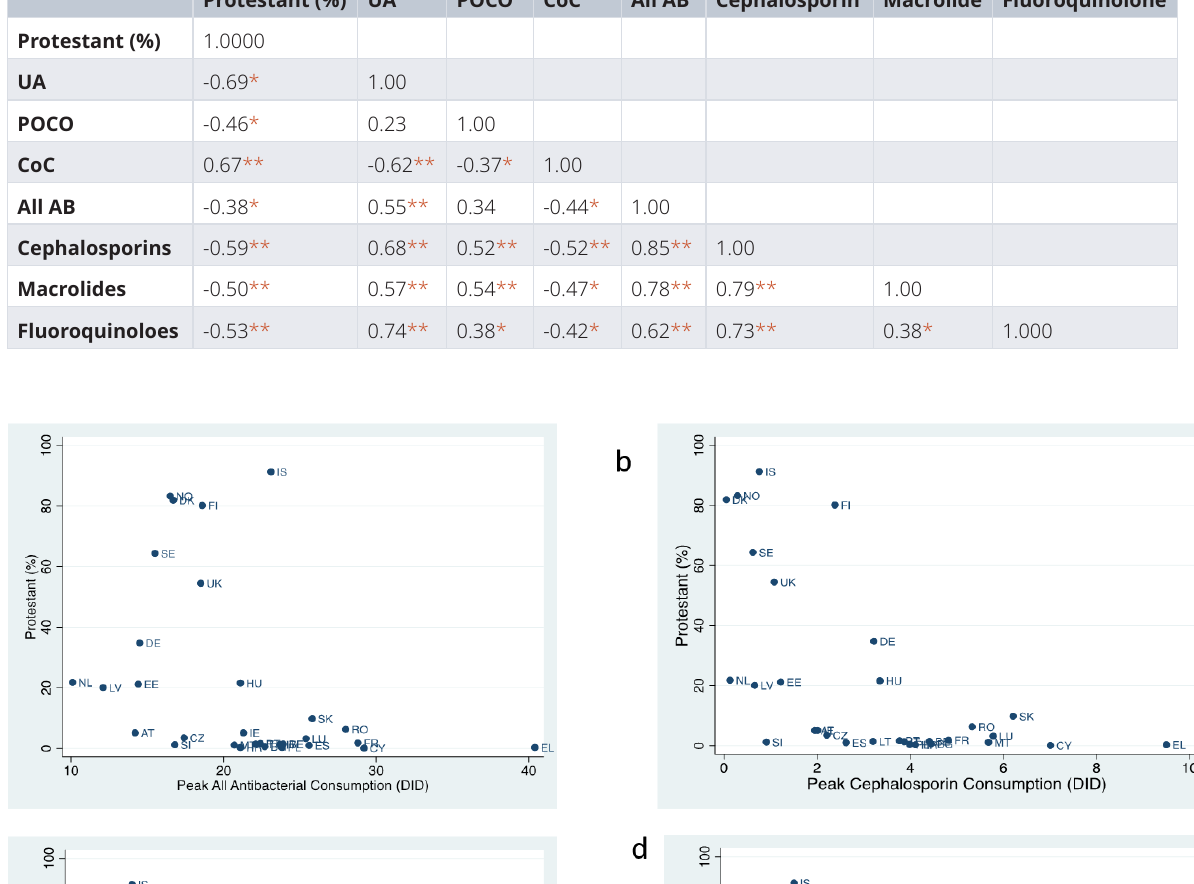
to be both hotter and more Catholic than Northern European countries. A previous ecological study has found that environ- mental temperature is associated with the prevalence of certain